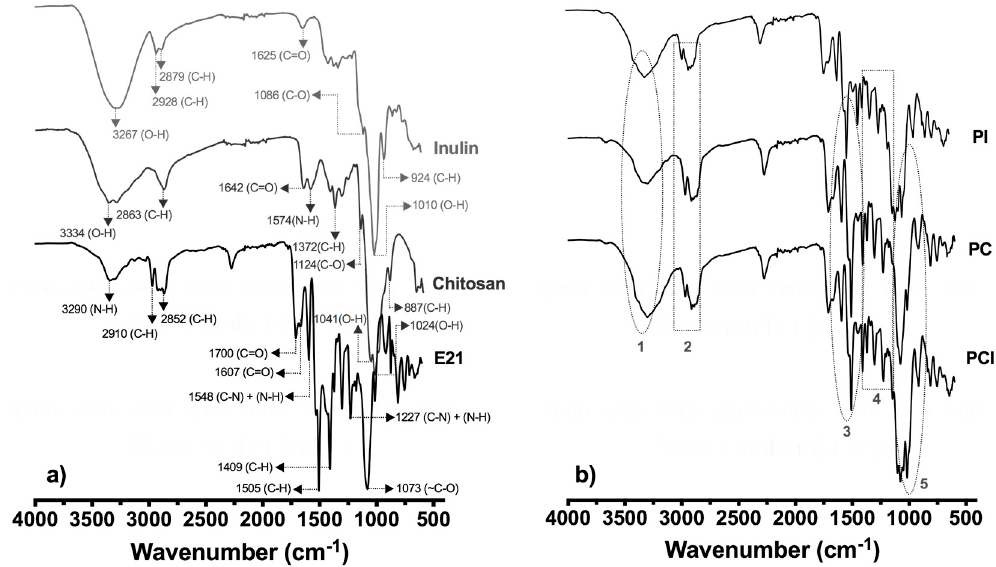
Figure 2. ( a ) Fourier Transform Infrared Spectroscopy (FTIR) spectra of the pure components used for manufacturing the materials; ( b ) FTIR spectra of blends components. PI = polyurethane/inulin, PC = polyurethane/chitosan, and PCI = polyurethane/chitosan/inulin.